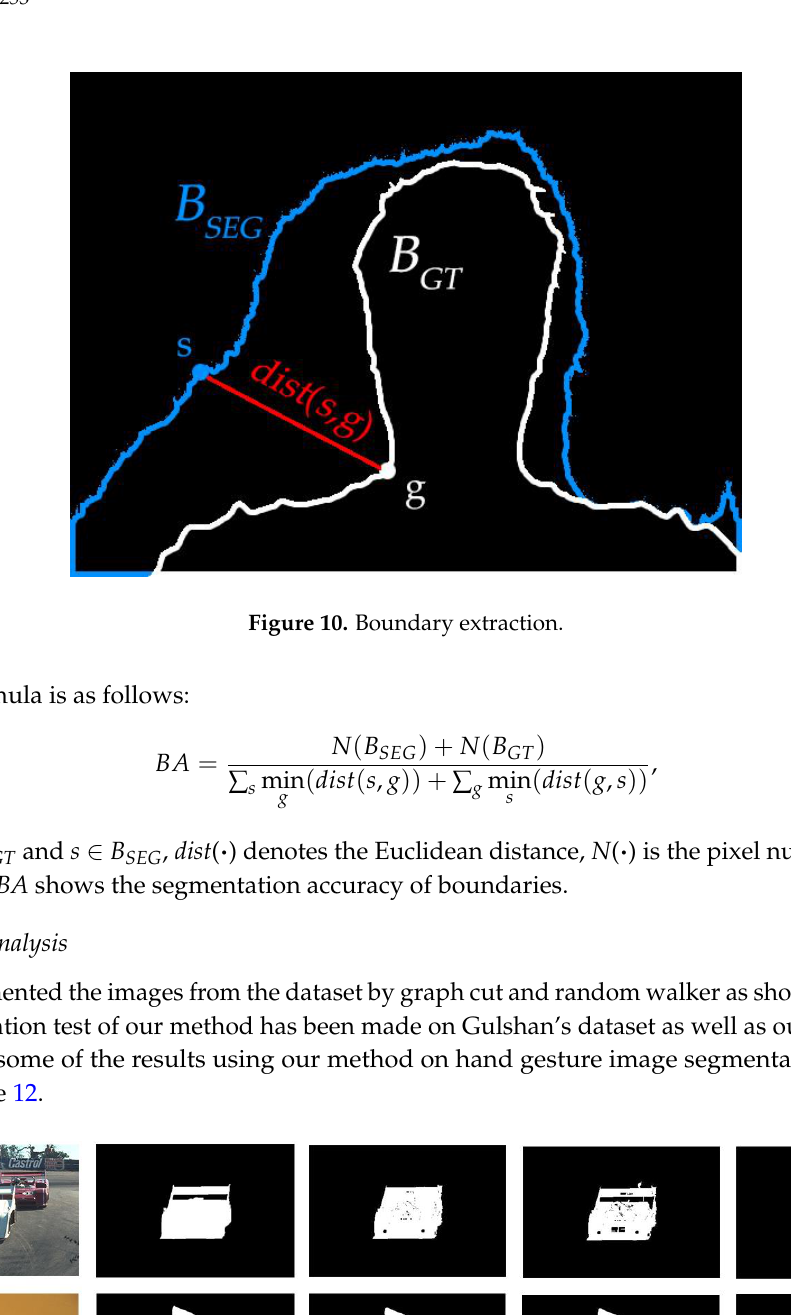
Figure 12. Segmentation results of our method on hand images. For a more rigorous test, we tested 151 images from Gulshan’s dataset and used the human interaction simulator to perform the interactions, which generated the seeds 20 times to further refine the segmentation results. The result of each simulation step has been tested on the experiment platform. The RA and BA scores are the mean values of 151 segmentations, shown in Figures 13 and 14. Figure 13. Region accuracy comparison.